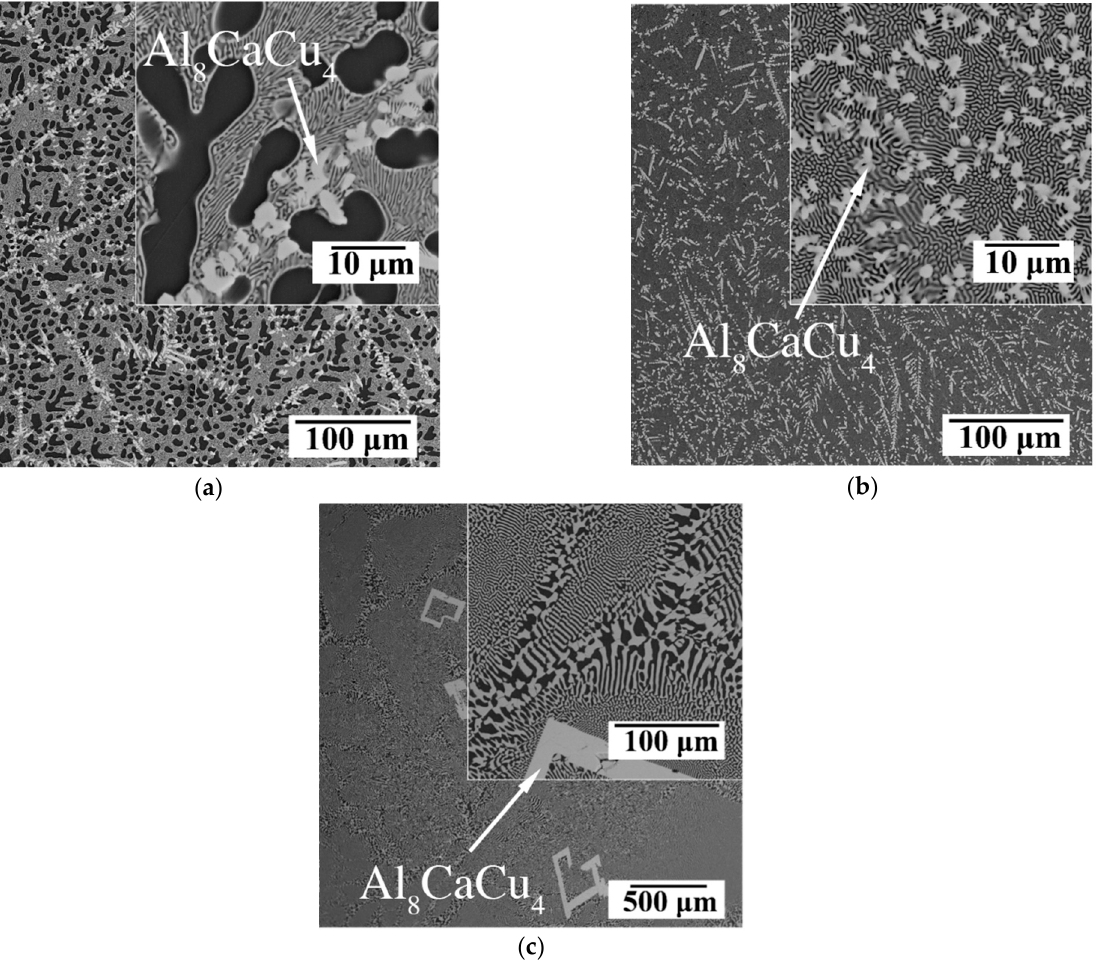
Figure 5. SEM microstructure of the alloys: ( a ) Al30Cu1.0Ca, and ( b , c ) Al36Cu1.0Ca for cooling rates of ( a ), ( b ) 10 K/s, and ( c ) 0.02 K/s. BSE.